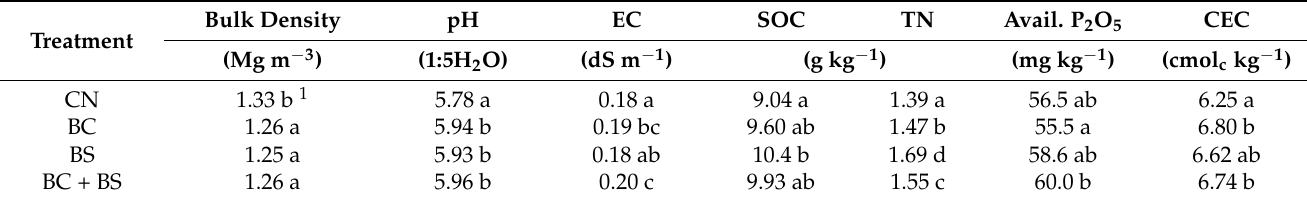
Table 1. Soil properties of experimental treatment sites after rice harvesting.